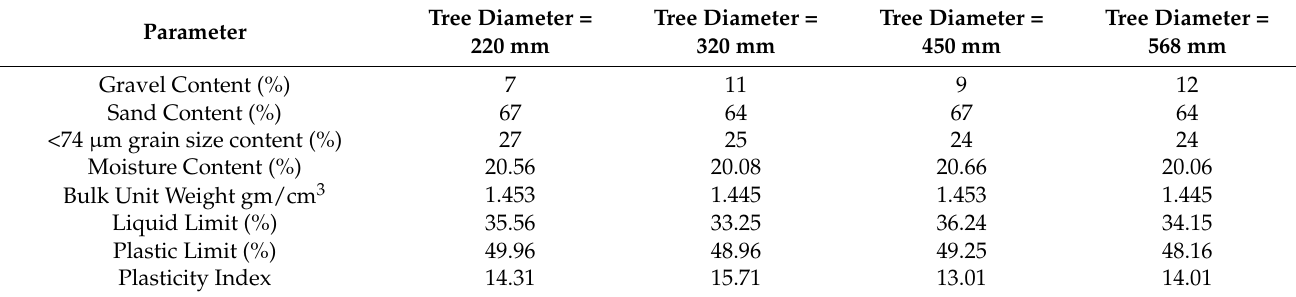
Figure 2. Gradation curves for the collected loess samples. Table 2. Description of soil at the investigated tree locations.